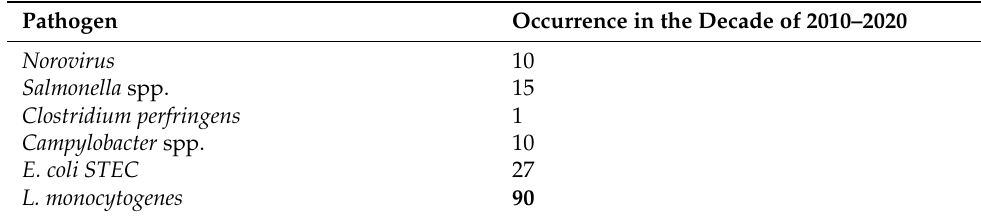
Table 2. Estimations of Hospitalization from Foodborne Illness based on best available data. The average is based on the number of people become ill and later hospitalized because of the severity of illness. For instance: for 10 persons ill with L. monocytogenes , estimated 9 people hospitalized [1,26,28].